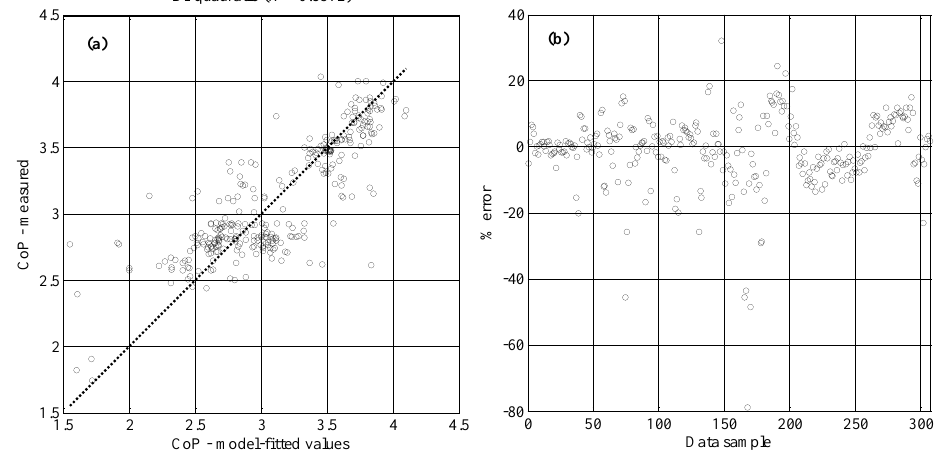
Figure 4. Bi-quadratic model fitting results. ( a ): Regression plot; ( b ): Target-model errors (%).